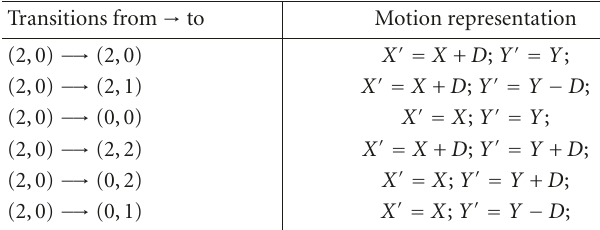
Table 2: Possible motion representation of state (2,0) given by state-transitions of the SIMM